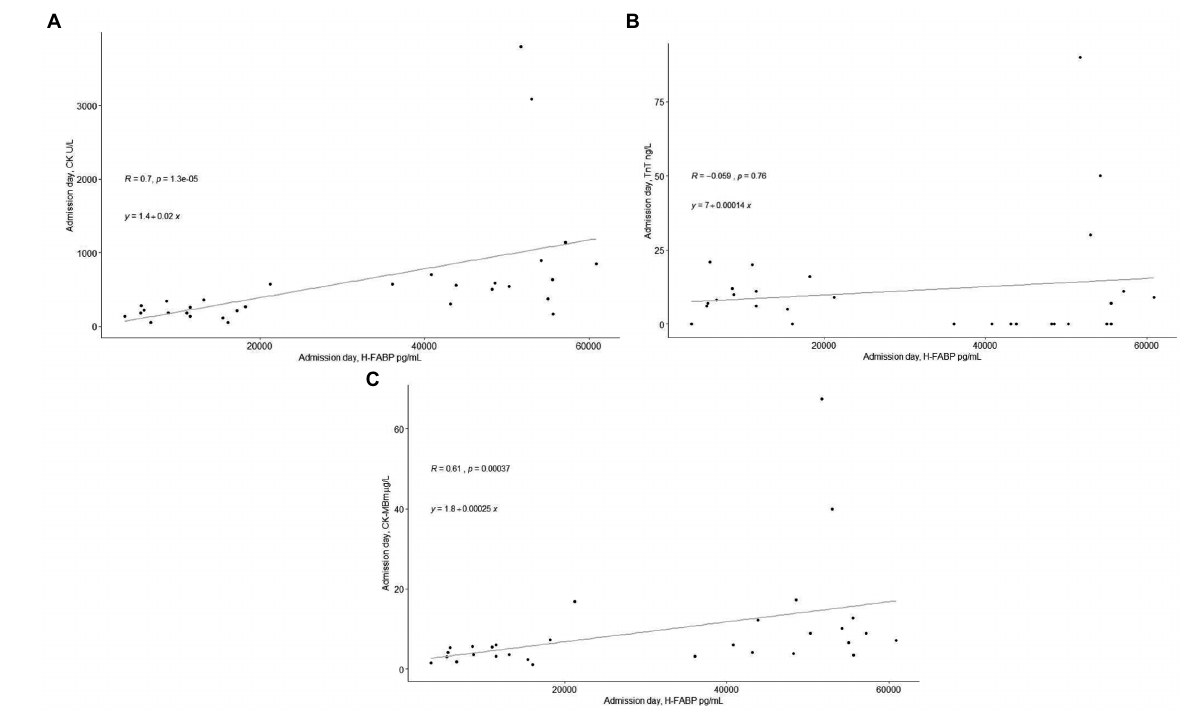
FIGURE 3 (A) The correlation between admission level of H-FABP with admission level of CK. (B) The correlation between admission level of H-FABP with admission level of TnT. (C) The correlation between admission level of H-FABP with admission level of